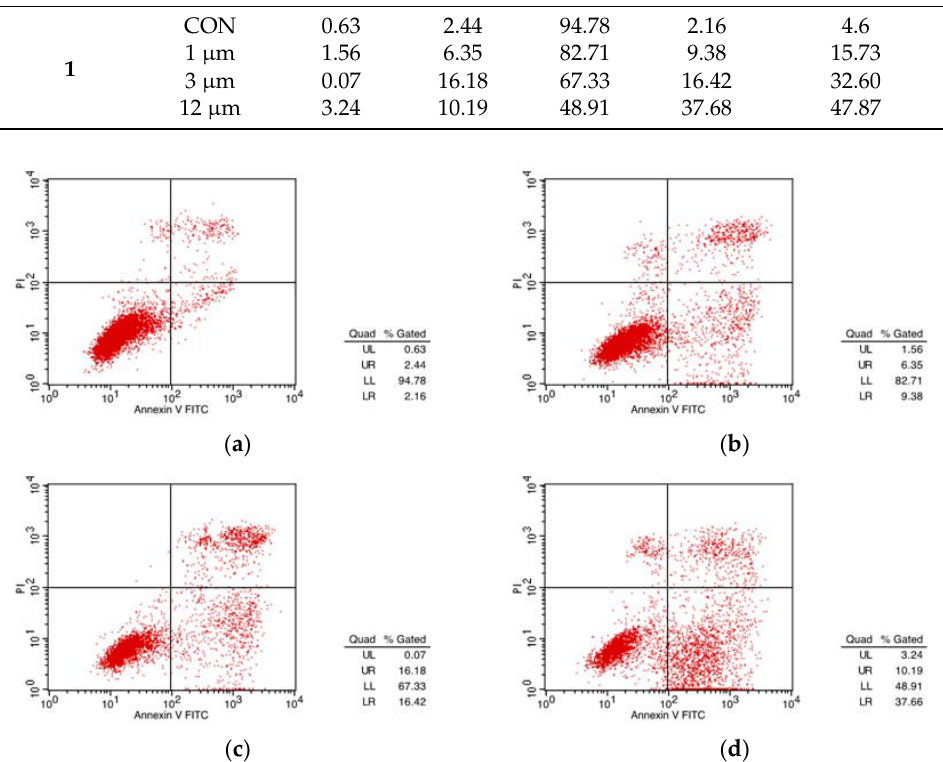
Figure 5. Compound 1 on the apoptosis rate of HepG2 cells: ( a ) control group; ( b ) 1 μ M; ( c ) 3 μ M; and ( d ) 12 μ M.